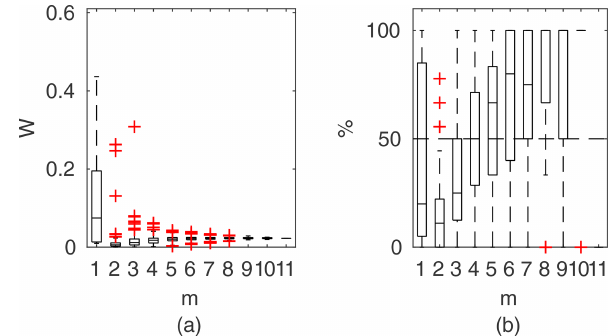
Figure B17. STLM results for the Ritobacken case study, autumn 2011: (a) averaged relative confidence widths W as a function of ob- servation set size m used for model identification; (b) percentage of verification points enclosed by the confidence intervals (100% de- notes all points within intervals, box spans over the 25% and 75% quantiles, the median is given with horizontal line, whiskers indi- cate the result extent, and cross marks are for extreme values).